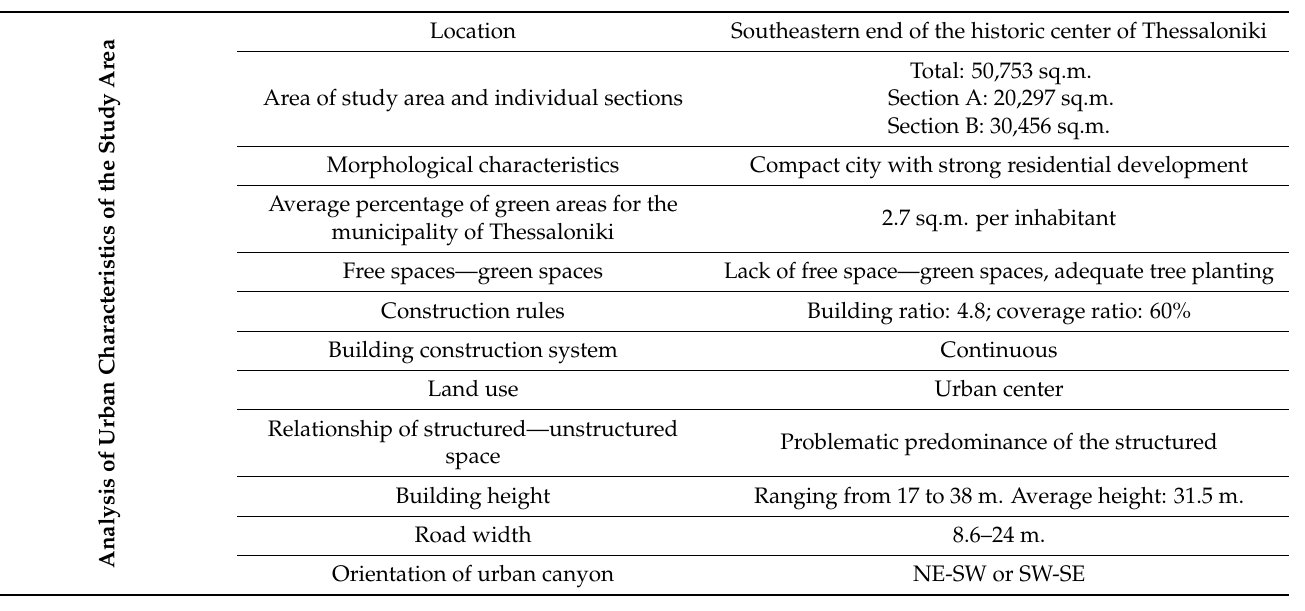
Table 1. Analysis of urban characteristics of the study area.